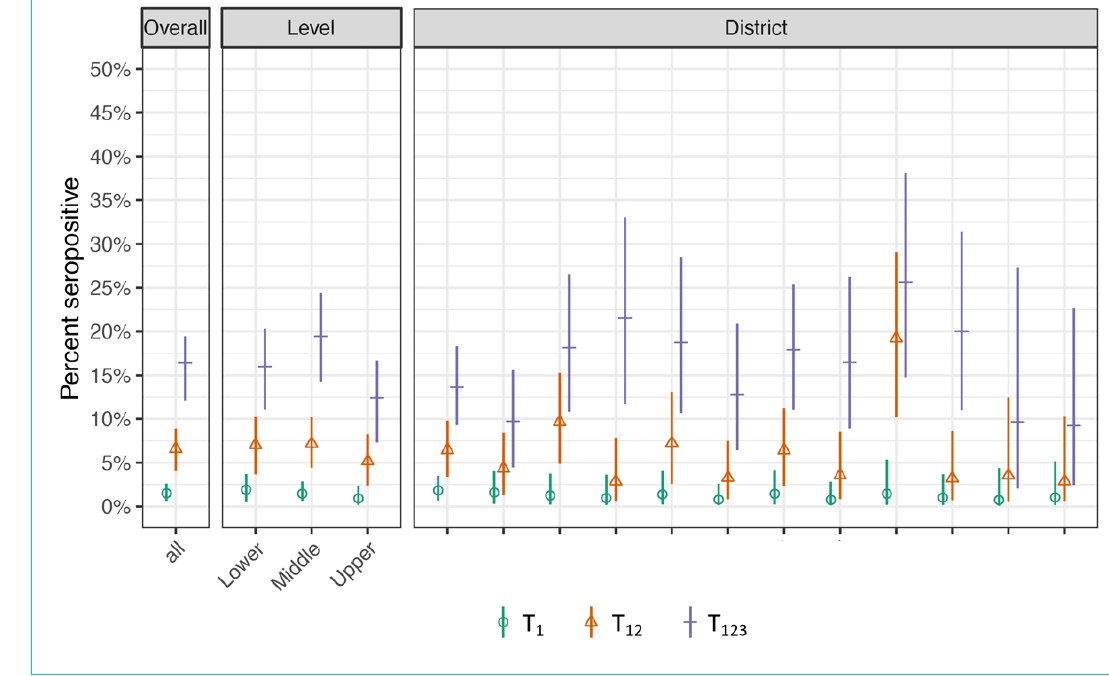
Figure 2: Proportion of ever-seropositive children in June-July 2020 (T1), October-November 2020 (T12) and March-April 2021 (T123). T1 – proportion of children testing seropositive by June-July 2020, T12 – by October-November 2020, T123 – by March-April 2021. Overall and school level specific estimates (lower school level: grades 1–2, children aged 6–10 years,; middle school level: grades 4–5, children aged 9–13 years; upper school level: grades 7–8, children aged 12–16 years; grades and age range are reported for time point of T1), and district specific estimates for the canton of Zurich, Switzerland. Districts are ranked by their population size, from largest to